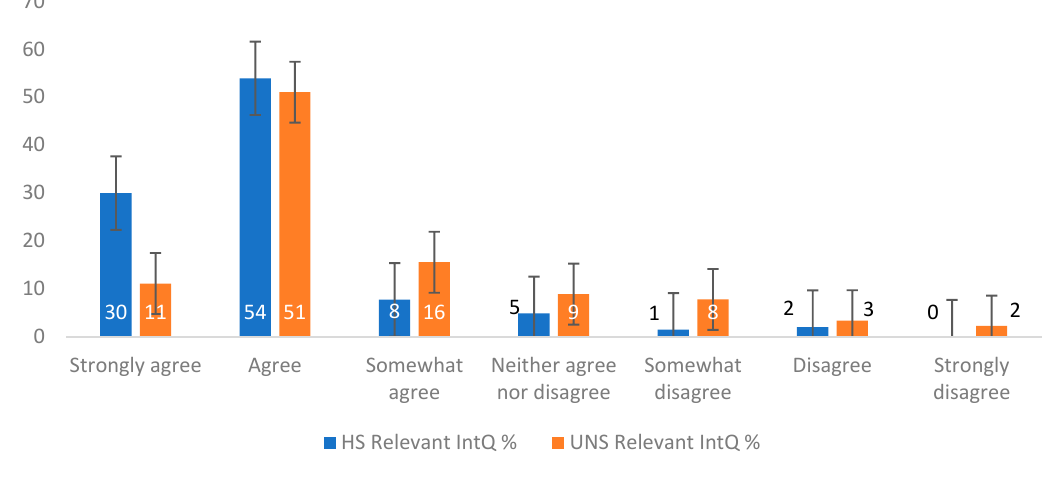
Figure 12. Relevant interview questions. Table 6. Applicant Perspective Hypothesis 4—Organised selection interview